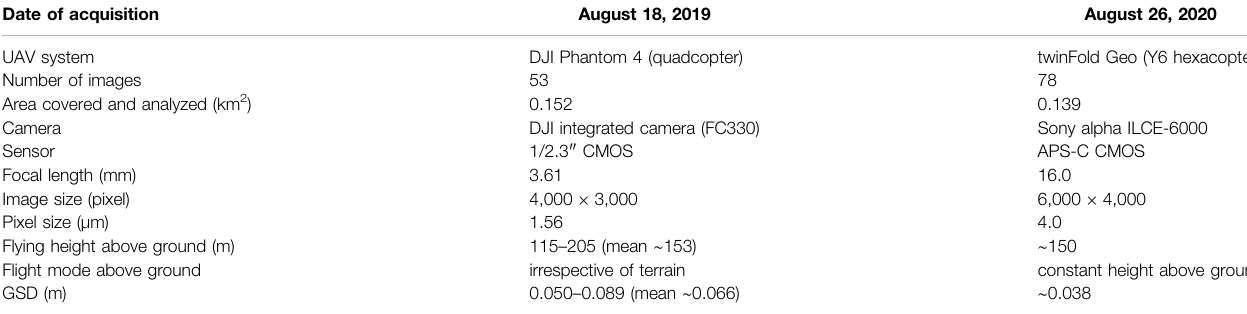
TABLE 2 | Technical parameters of the UAV-based aerial surveys 2019 and